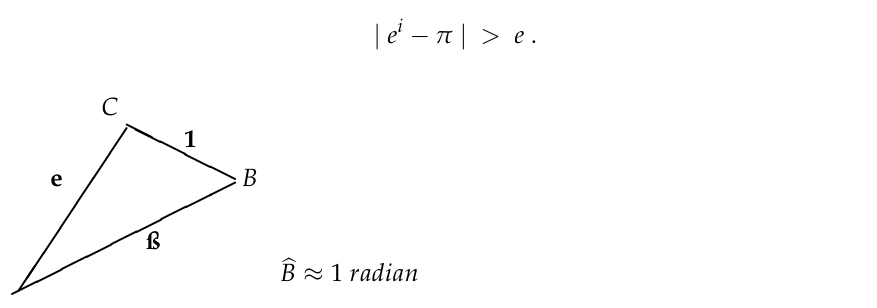
Figure 1. The inequality | e i − π | > e , could also be read as | e i − π | ≈ e